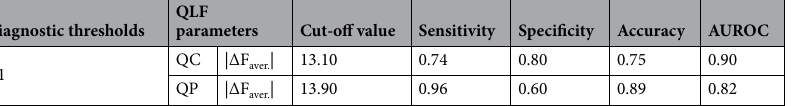
Table 3. Cut-off values and validity of QLF parameters for detecting secondary dental caries. Quantitative light-induced fluorescence (QLF); Qraycam Pro® (QP); Qraypen C® (QC).